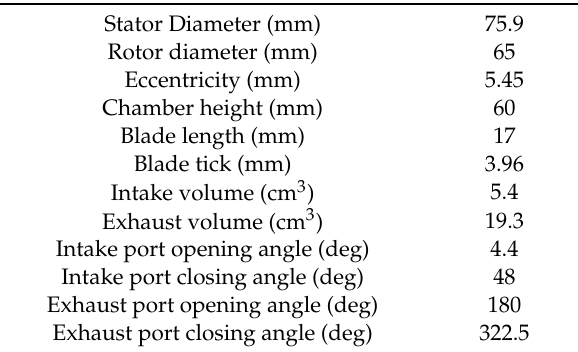
Table 1. Expander geometry and angle of ports.